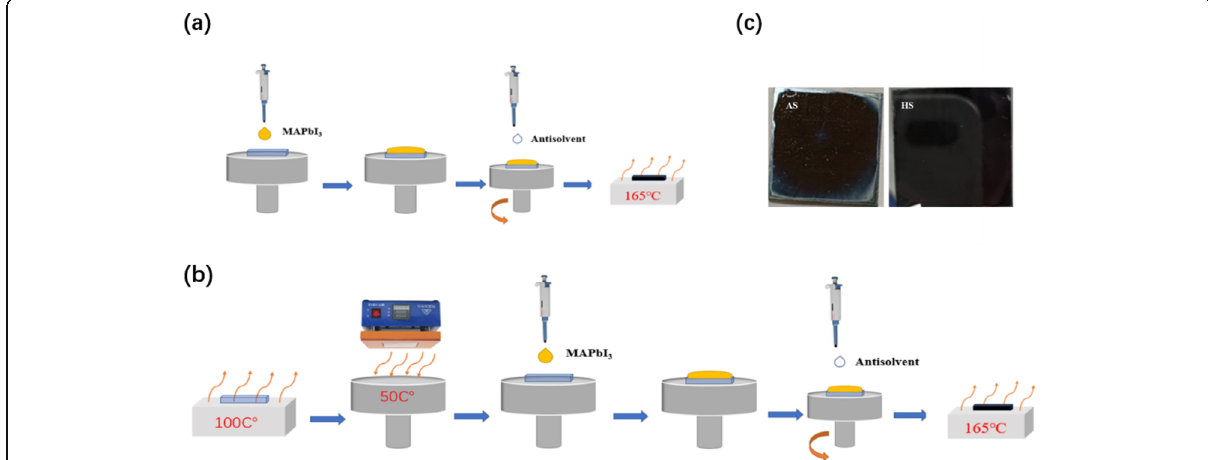
Fig. 1 a Anti-solvent spin-coating method of perovskite film, b heat anti-solvent spin-coating method of perovskite film, c photograph of perovskite deposited with different